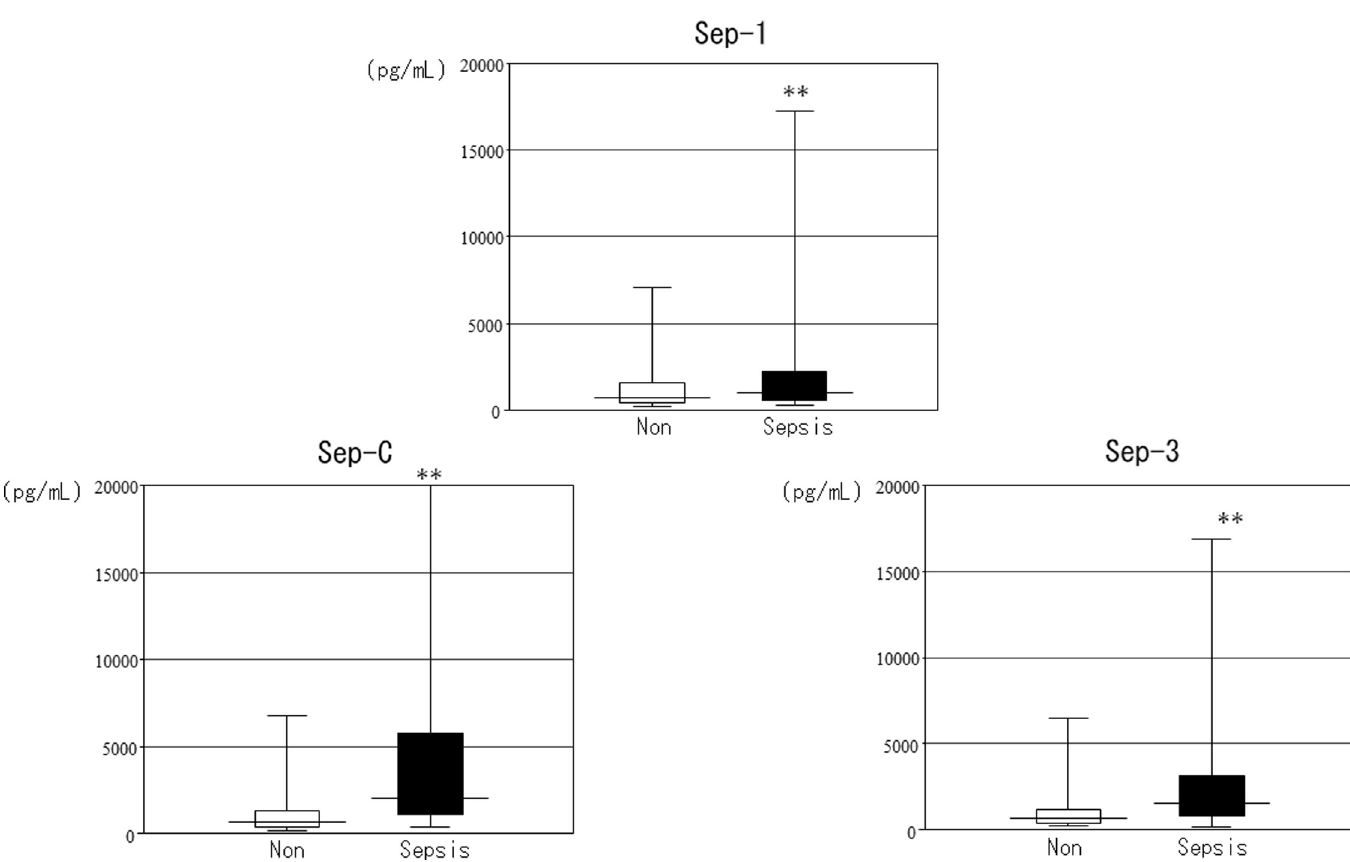
Fig 6. Comparison of Pre levels in patients with and without each sepsis diagnosis[patients with eGFR < 60 (N = 280)]. The horizontal bars represent the median, the boxes represent the IQR, and the vertical bars represent the upper and lower limits. Non: The group of non-septic patients. Sepsis: The group of septic patients. The median Pre (IQR) values are as follows: Sep-1: Sepsis (N = 138), 1014 (563–2209) vs. Non (N = 142), 692 (379–1566) pg/mL; Sep-C: Sepsis (N = 54), 2056 (1068–5775) vs. Non (N = 226), 698 (399–1284) pg/mL; Sep-3: Sepsis (N = 72), 1546 (788–3164) vs. Non (N = 157), 674 (398–1207) pg/mL. � p < 0.05, �� p < 0.01 by the Mann–Whitney U test vs.